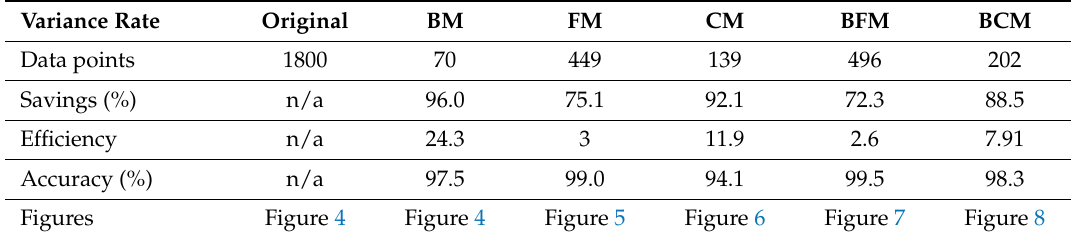
Table 2. Summary of samples and inference results. Efficiency rate is not shown in this table as it